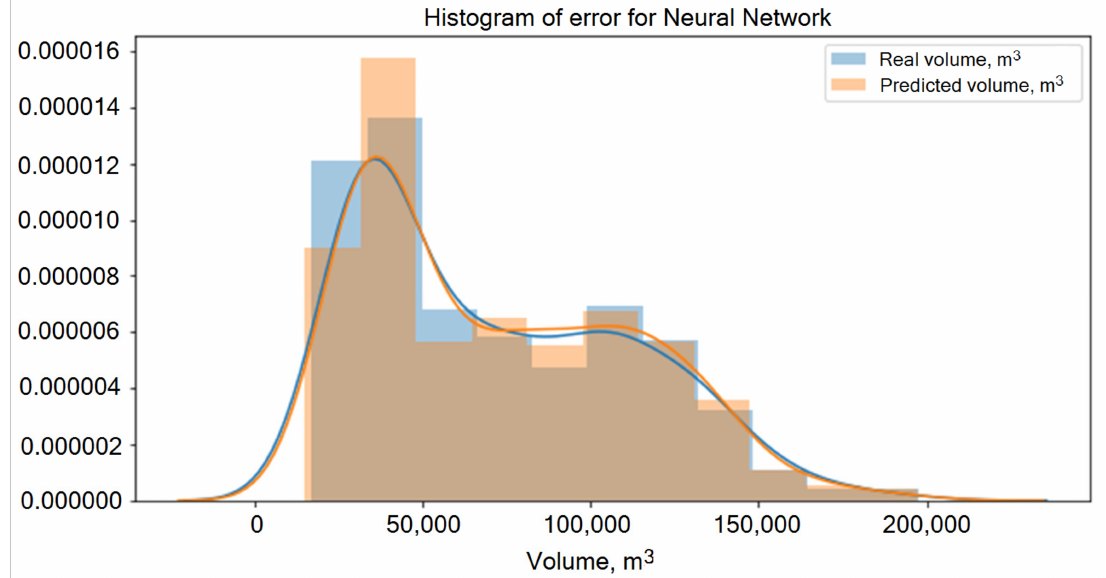
Figure 12. Predicted and actual value error histogram for